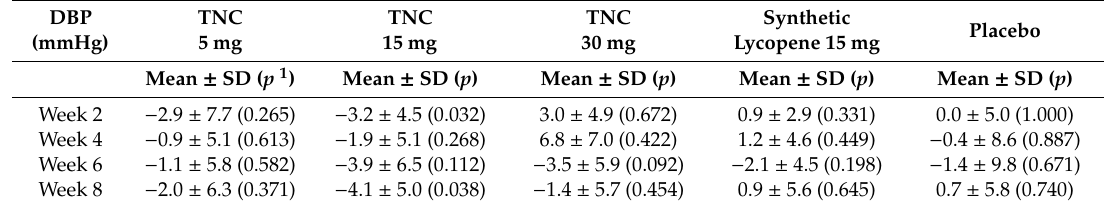
Table 4. Change in DBP from baseline during eight weeks of treatment.